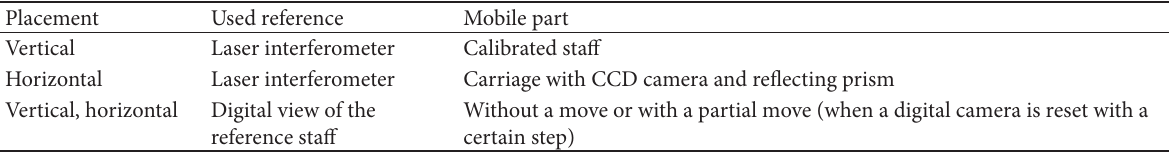
Table 1. Principal structure of